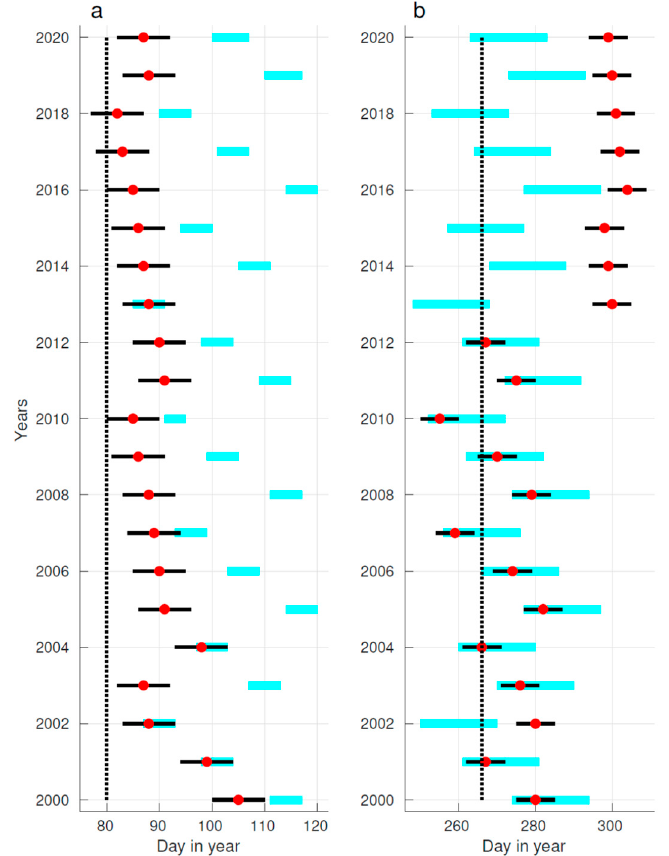
Figure 2. The 2000–2020 dates of DST clock changes (red dots), with five days periods before and after them marked by thin black lines (see Section 2.3) and the Jewish holiday periods marked by thick cyan lines. ( a ) Spring DST; ( b ) autumn DST. The vertical dotted lines denote the spring and autumn equinox days.